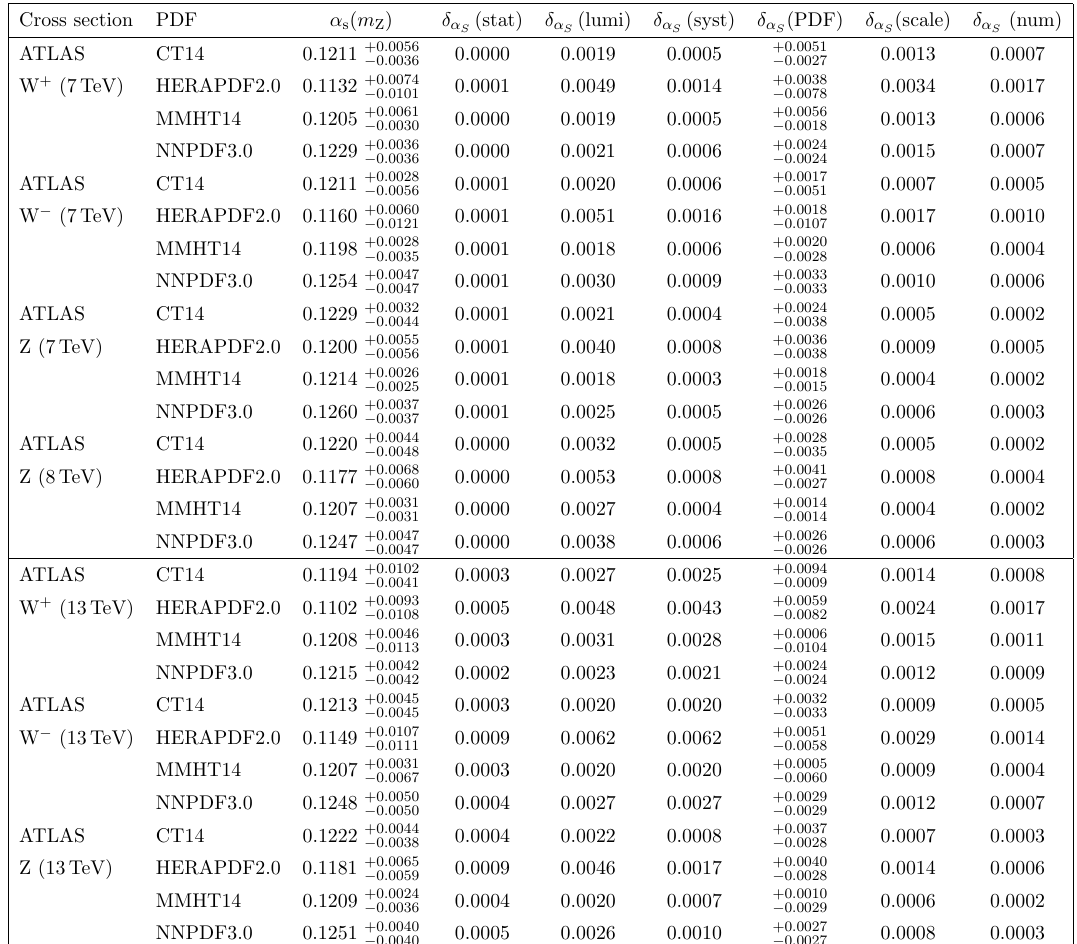
Table 15 . Extracted (cid:11) s ( m Z ) values from the comparison of the W + , W (cid:0) , and Z boson production cross sections measured by ATLAS to NNLO pQCD predictions. For each measurement, four results are extracted, one per PDF set. The breakdown of the propagated uncertainties from di(cid:11)erent experimental (statistical, integrated luminosity, and systematic) and theoretical (PDF, scale, and numerical) sources is provided for each (cid:11) s ( m Z ) estimate.